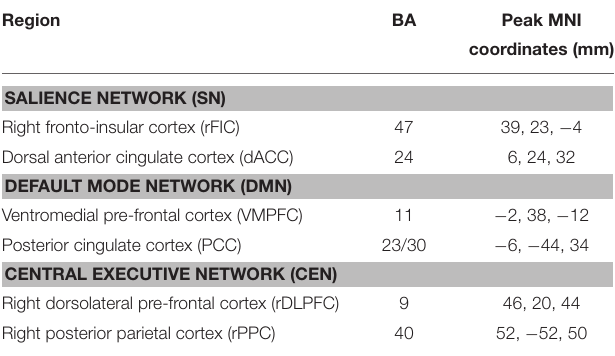
TABLE 1 | Coordinates of